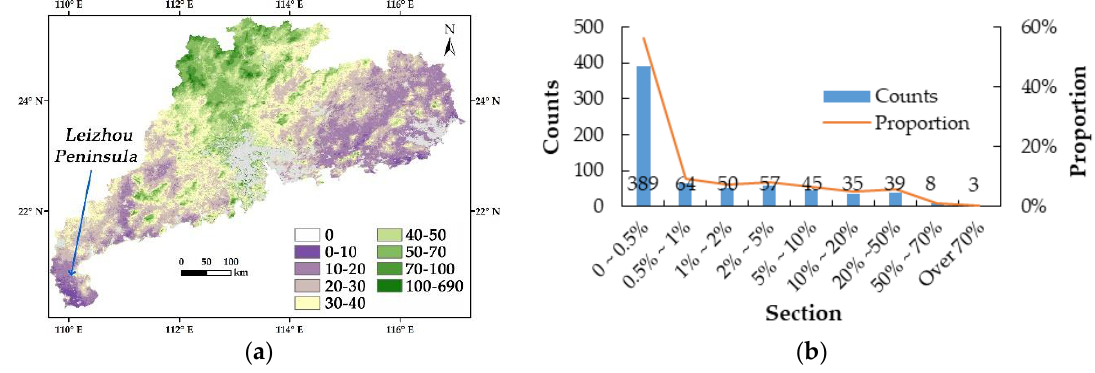
Figure 5. Spatial distribution ( a ) and statistical chart ( b ) of missing data.